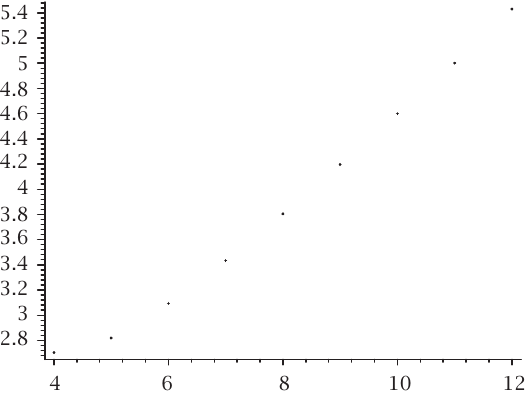
Figure 4.1 . The expectations computed by Theorem 3.1 and